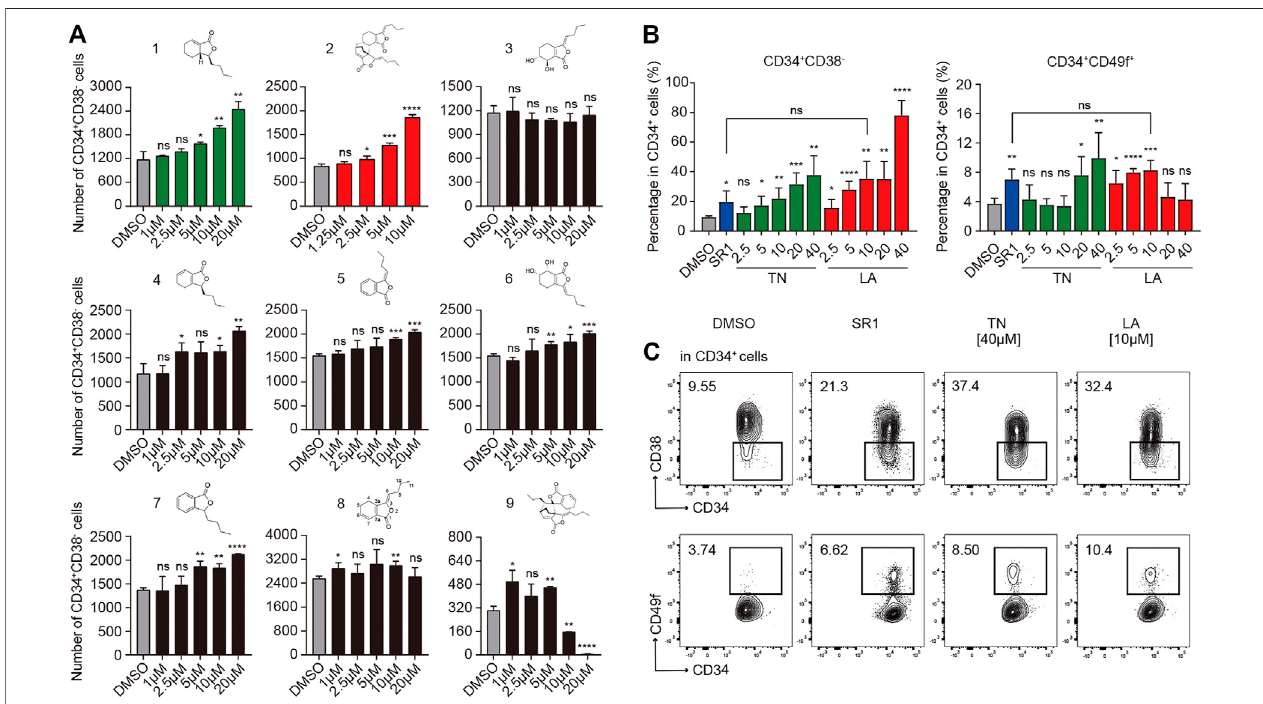
FIGURE 1 | Identi fi cation of proliferative activities of phthalide derivatives 1 to 9 and the optimal working concentration of candidate compounds for in vitro expansion of human UCB CD34 + cells. (A) The structures of phthalide derivatives 1 to 9 and the corresponding absolute number of CD34 + CD38 − cells after a serum- based7-d culture ingradientconcentrationsasspeci fi ed( n = 6). (B) The percentagesofCD34 + CD38 − and CD34 + CD49f + subpopulationsinCD34 + cellsafter aserum- based7-dculturesupplementedwithDMSO (0.05%, v/v),SR1(1 µM), Levistilide A(LA,2.5 – 40 µM),orTetrahydrophthalide Neocnidilide (TN, 2.5 – 40 µM) ( n =5). (C) Representative FACS pro fi les of CD34 + CD38 − and CD34 + CD49f + subpopulations in cultured CD34 + cells as described in (B) . All data represent the means ± SD. Compared with fresh unless speci fi ed. * p < 0.05, ** p < 0.01, *** p < 0.001, **** p < 0.0001 and ns = not signi fi cant by two-tailed unpaired Students ’ t